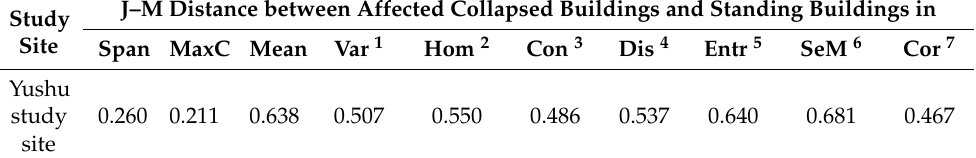
Table 3. J–M distance between affected collapsed buildings and standing buildings in different GLCM texture